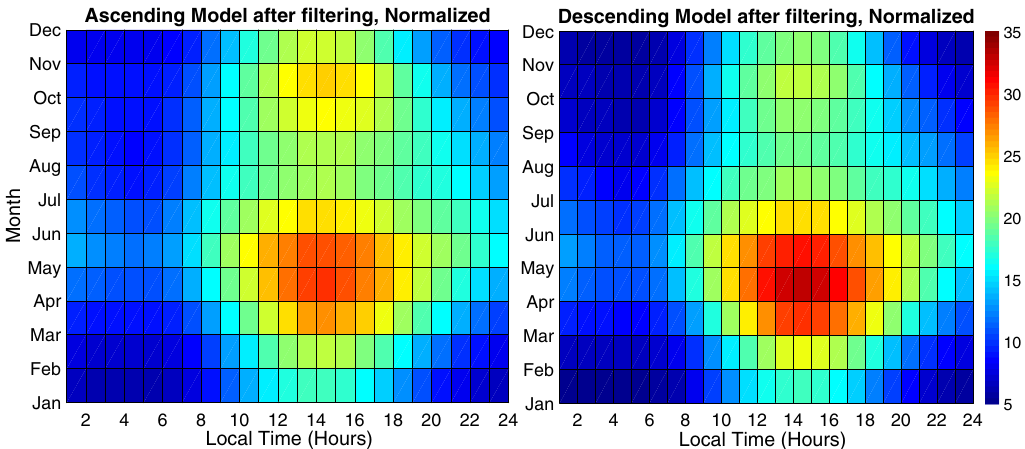
Figure 14. Final Result of Ionospheric model - Normalized to F10.7 = 100 SFU.